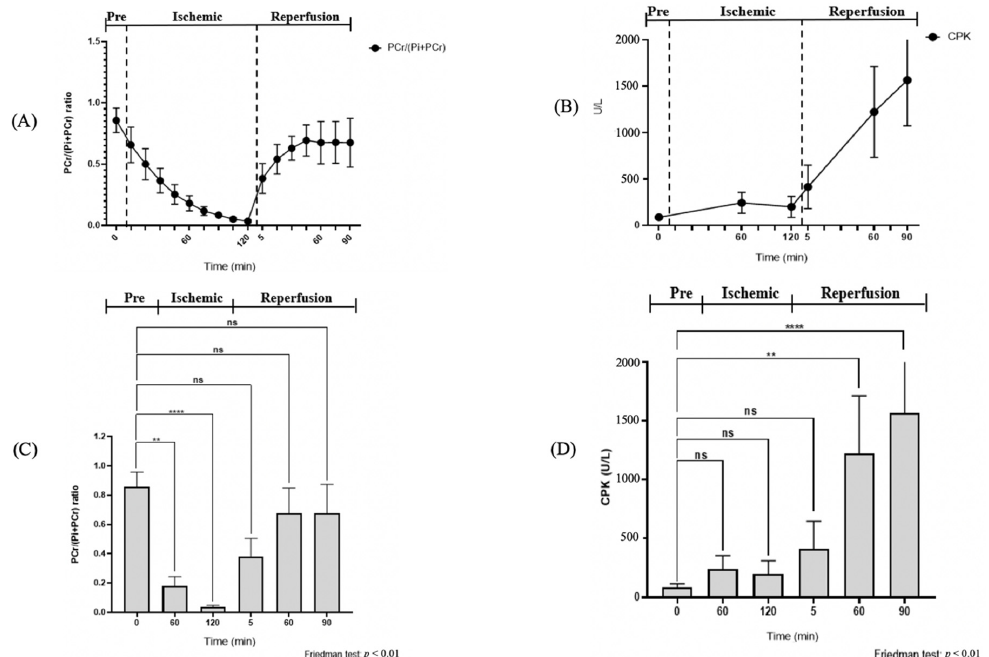
Figure 7. Dynamics in the ratio of PCr/(Pi + PCr) and concentration of CPK during the ischemic and reperfusion states. ( A , B ) Changing of the PCr/(Pi + PCr) ratio and CPK of rat skeletal muscles during 2 h of the ischemic and 1.5 h of the post-ischemic states. ( C , D ) Comparison of the quantitative PCr/(Pi + PCr) ratio and CPK at 0, 60, 120, 125, 185, and 215 min before, during, and after ischemia. ns (not significant); ** (0.001 < p < 0.005) and **** ( p < 0.0001), based on the Friedman test.